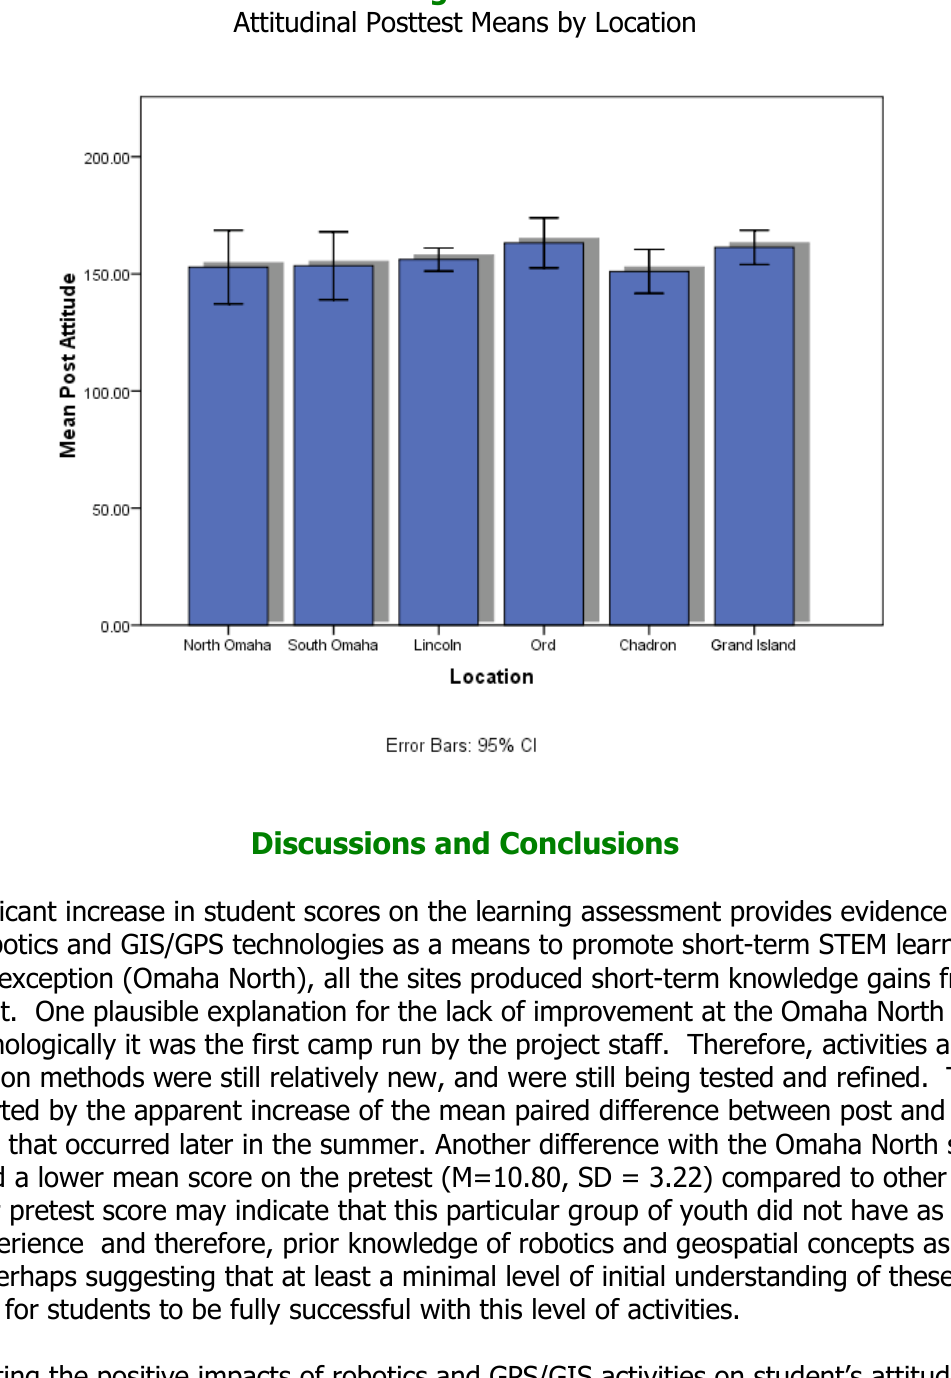
Attitudinal Posttest Means by